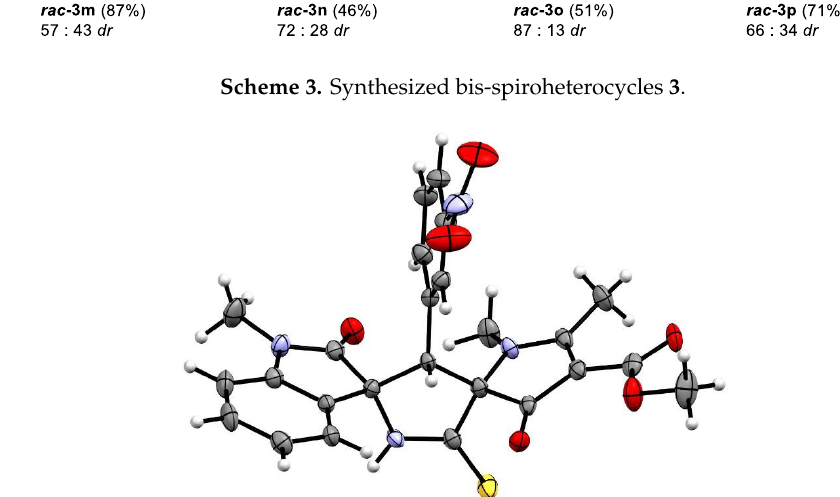
Figure 3. Single crystal X-ray structure depicting product 3b . Thermal ellipsoids are shown at 50% probability.